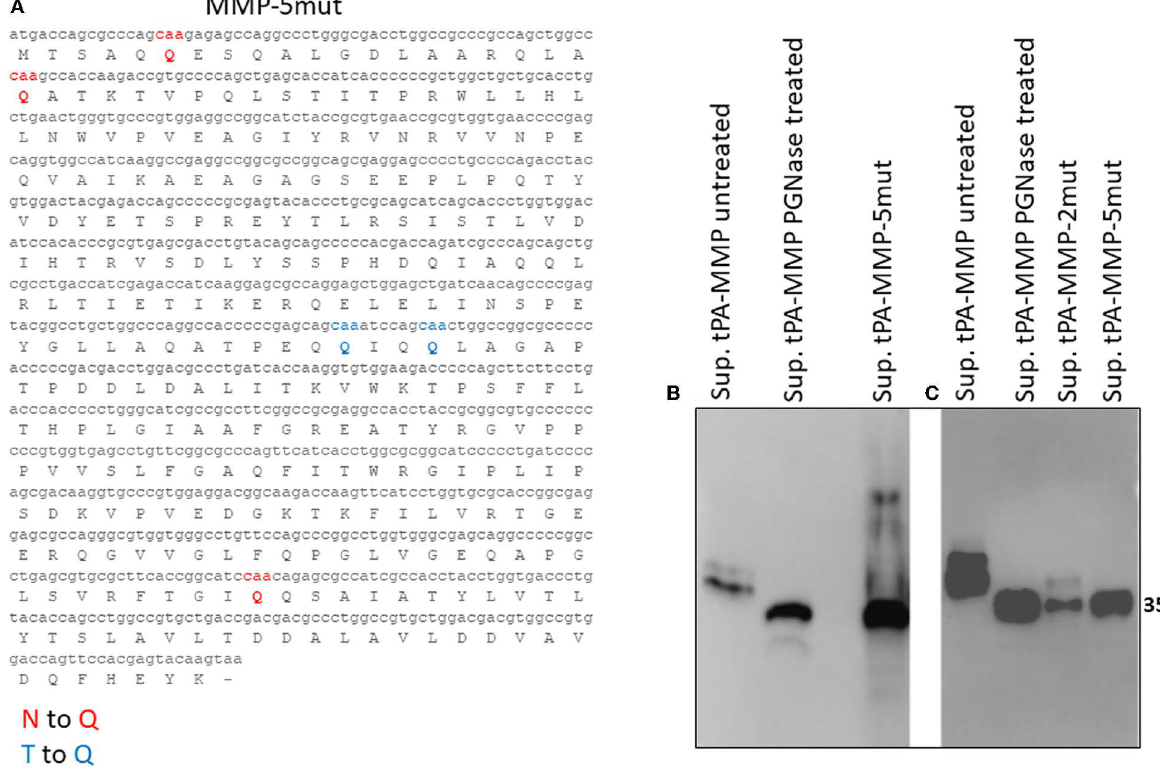
FIGURE 4 | (A) Mutated MMP protein sequence (tPA-MMP-5mut), where the predicted N-linked asparagine residues were substituted with glutamine (Q, red) and the predicted O-linked threonine residues were also substituted with glutamine (Q, blue). (B) Western immunoblot of secreted tPA-MMP-5mut (Sup tPA-MMP-5mut) compared with tPA-MMP treated or untreated with PNGase. tPA-MMP-5mut and tPA-MMP treated with PNGase exhibit the same electrophoretic mobility. (C) Western immunoblot of secreted tPA-MMP-5mut (Sup tPA-MMP-5mut) compared with tPA-MMP-2mut (Sup tPA-MMP-5mut) and tPA-MMP treated or untreated with PNGase. tPA-MMP-5mut, tPA-MMP-2mut, and tPA-MMP treated with PNGase exhibit the same electrophoretic